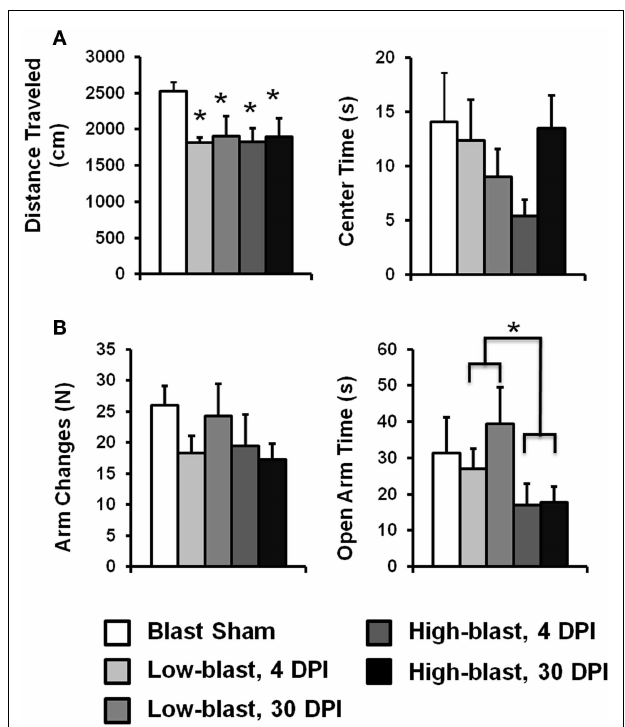
FIGURE 4 | Open field test and elevated plus maze . Emotionality and anxiety was examined with the Open FieldTest (A) and the Elevated Plus Maze (B) for each of the four blast conditions and sham group. Error bars indicate SEM. * p <